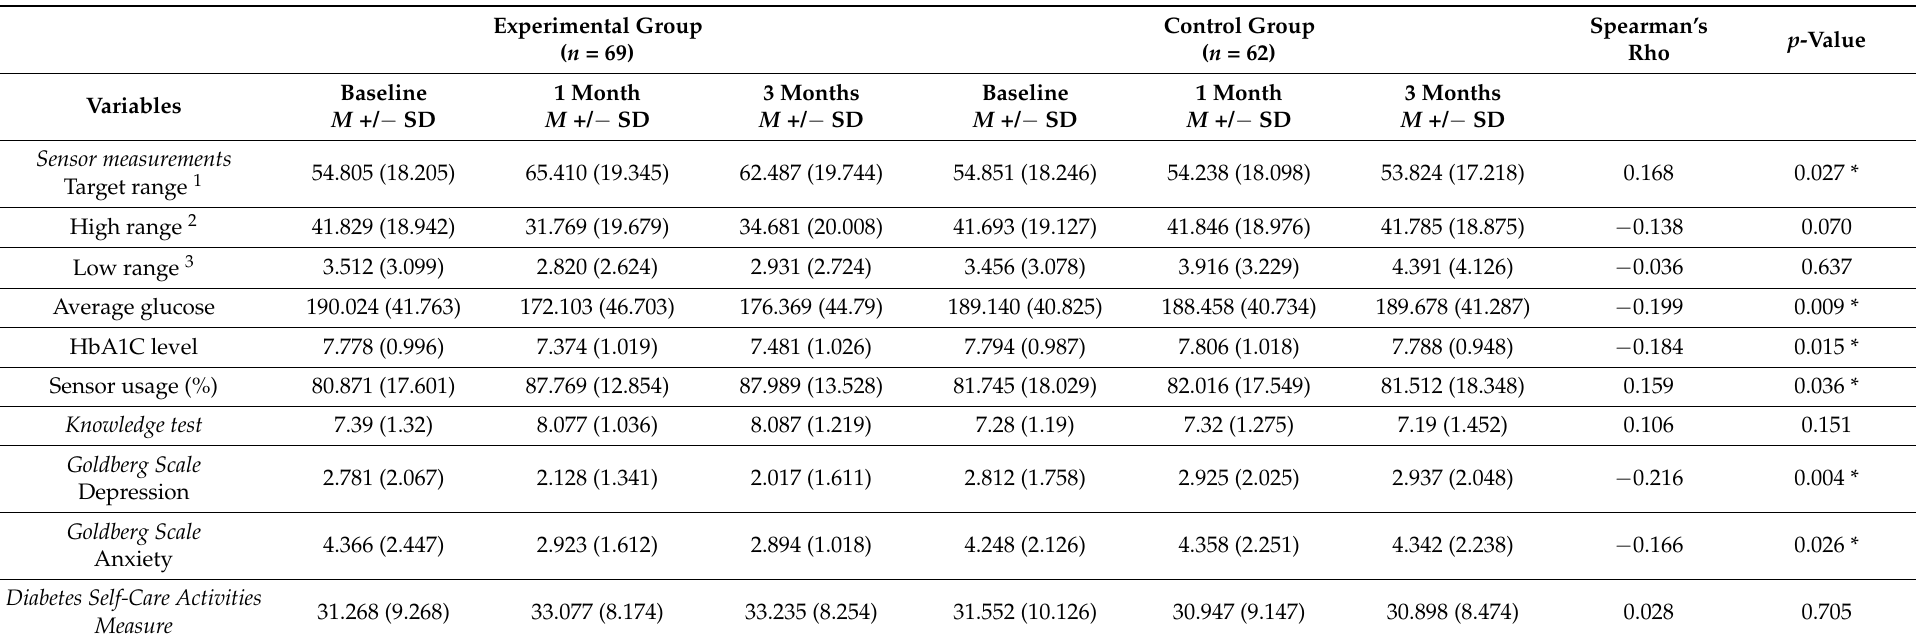
Table 3. Analysis of baseline, 1 month, and 3 months evaluations of different groups. Experimental